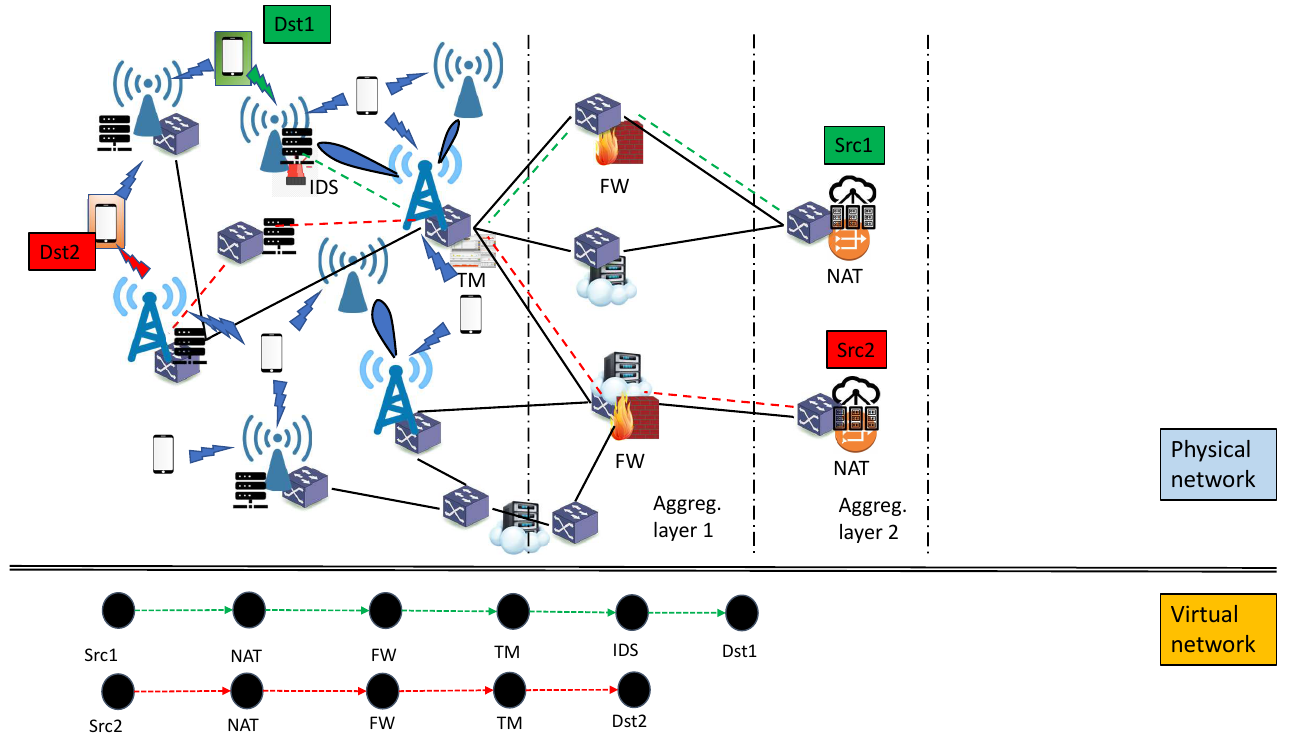
Figure 2. Embedding of virtual network (bottom part) into the physical network (top part). For illustration, 2 distinct SFCs are shown (in green and red) corresponding to 2 different UE requests, and each SFC is described by its own virtual network. G ( ρ 1 ) (green color) contains 6 virtual nodes and 5 virtual edges, whereas G ( ρ 2 ) contains 5 virtual nodes and 4 virtual edges. The virtual nodes will be mapped to actual physical nodes, while the virtual edges will be mapped to actual paths in the physical